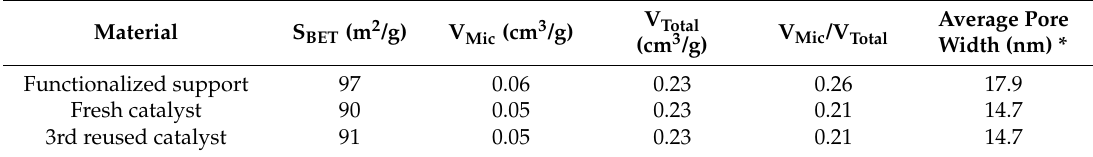
Table 1. Textural properties of the materials.